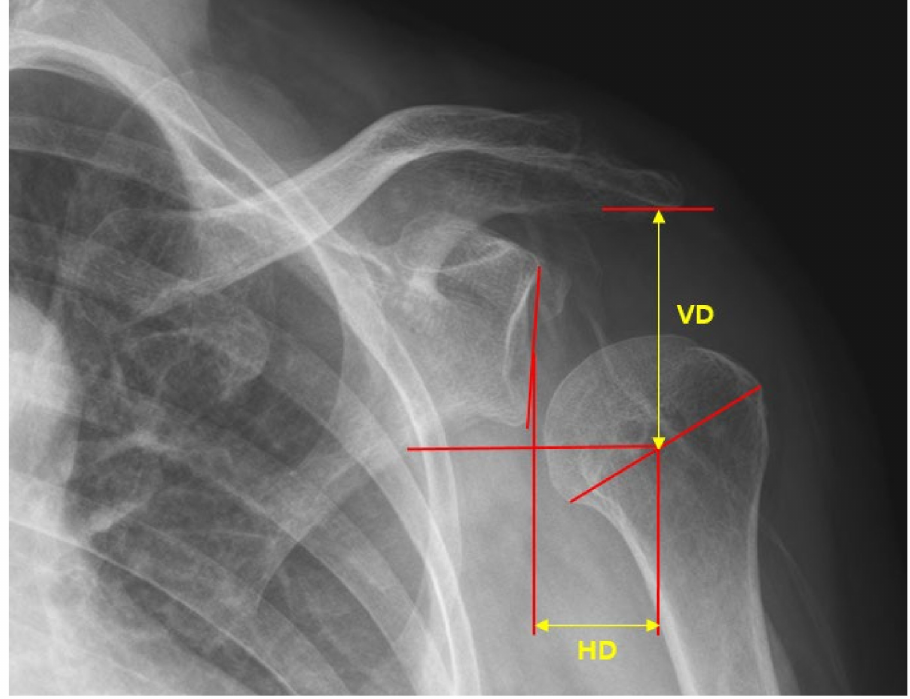
Figure 4. Measurement of horizontal distances (HD) and vertical distances (VD) in a true anteropos- terior